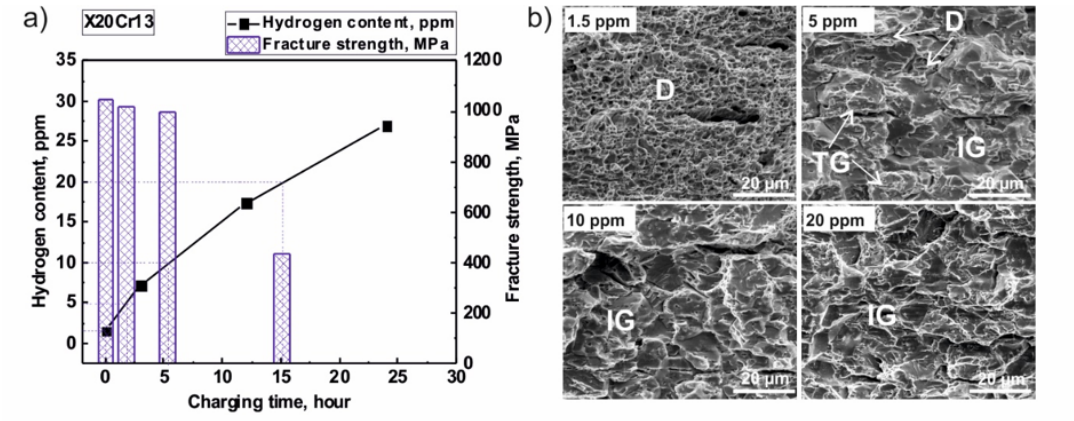
Figure 1. Hydrogen induced cracking in a cold rolled X20Cr13 martensitic stainless steel. ( a ) the evolution of hydrogen contents according to the hydrogen charging time and the fracture strength according to the hydrogen charging time determined by a slow strain rate test at the strain rate of 10 − 6 s − 1 ; ( b ) fracture surfaces from the failed slow strain rate specimens with different amounts of pre-charged